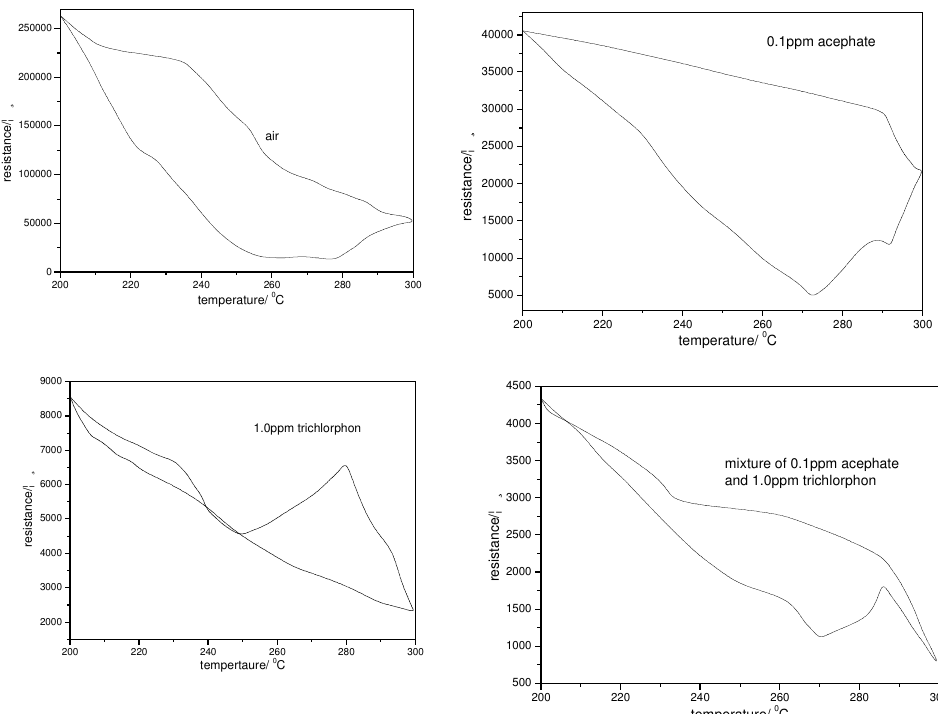
Figure 6. Characteristic response of resistance versus temperature curve for air, 0.1ppm acephate, 1.0ppm trichlorphon and mixture of 0.1ppm acephate and 1.0ppm trichlorphon. A square voltage (f=20mHz) was applied to the heater of the sensor. The temperature was changed approximately